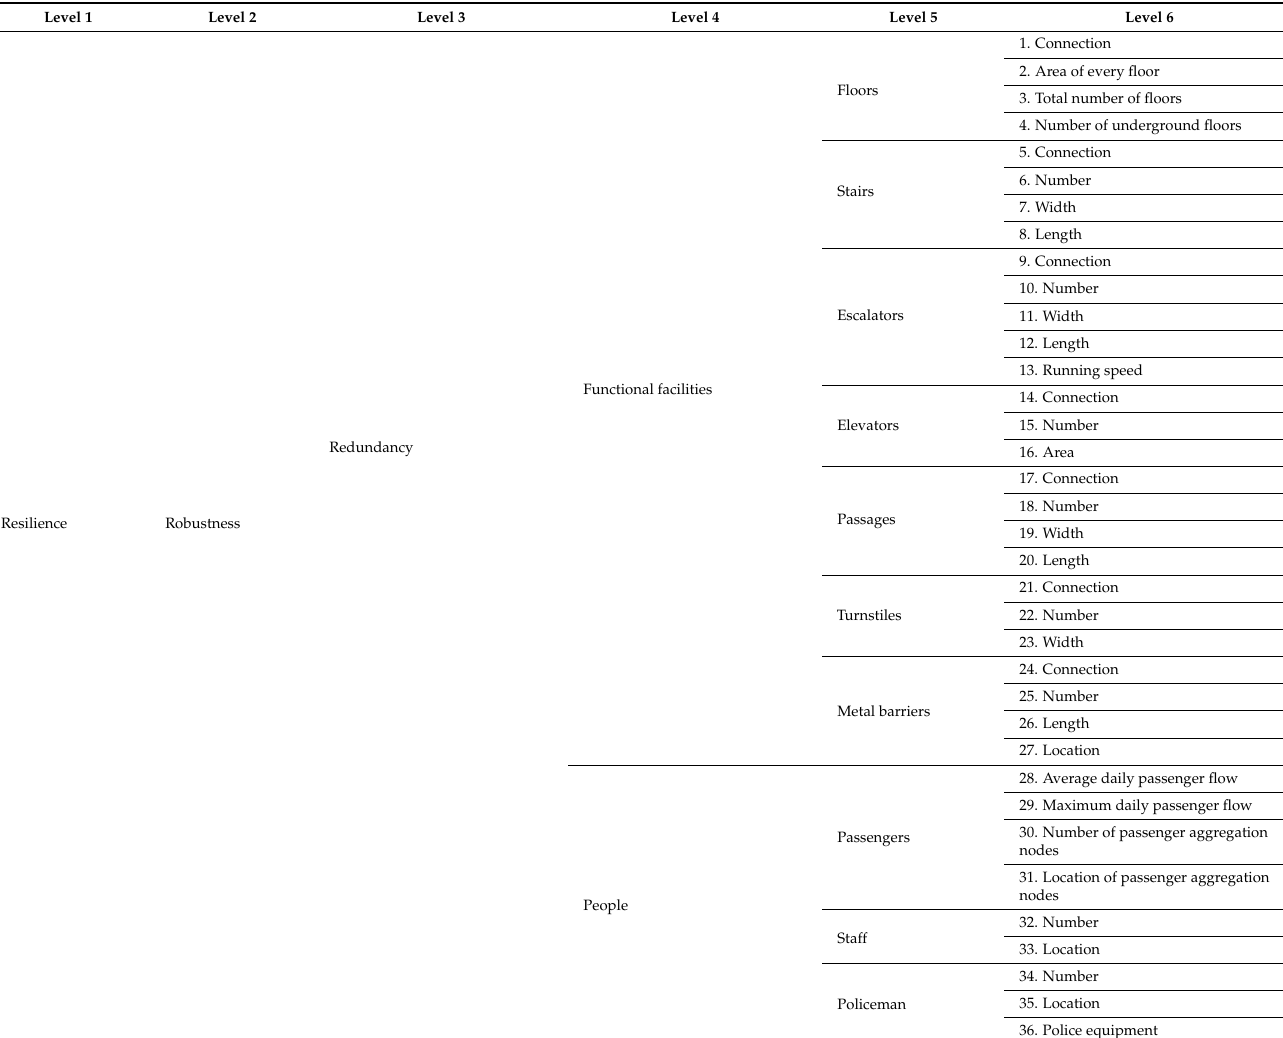
Table A1. Resilience indicators of